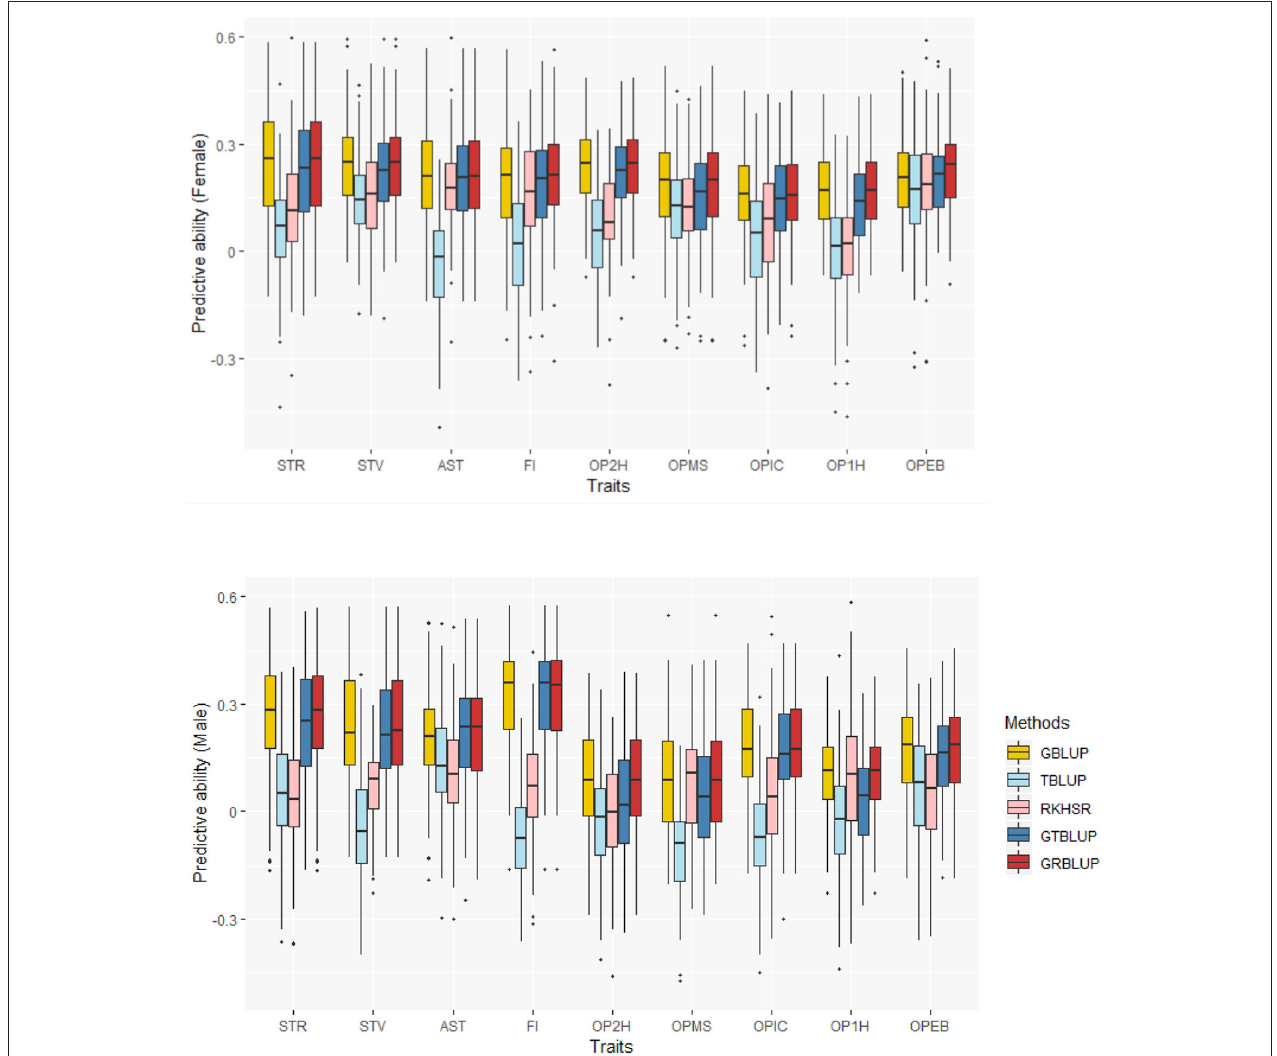
FIGURE 2 | Predictive abilities for nine traits with five statistical models in females and